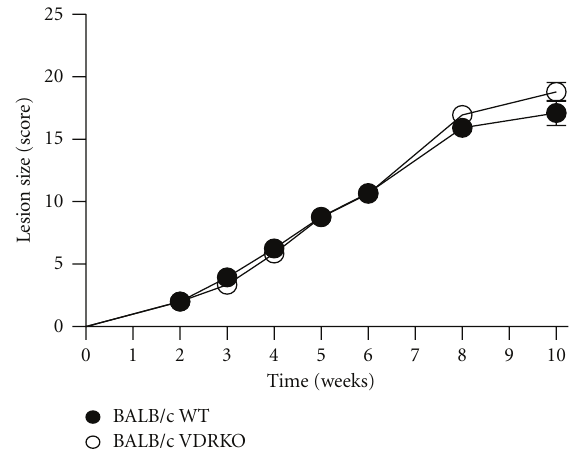
Figure 3: Deficiency of vitamin D signaling does not modulate resistance in a susceptible mouse strain. VDRKO mice on a susceptible BALB/c background (open circles) or WT BALB/c (closed circles) were infected with 10 5 L. major parasites and the resulting lesions were measured at the indicated time points. Mean ± SE is presented; n = 14. One representative of two independent experiments is presented.